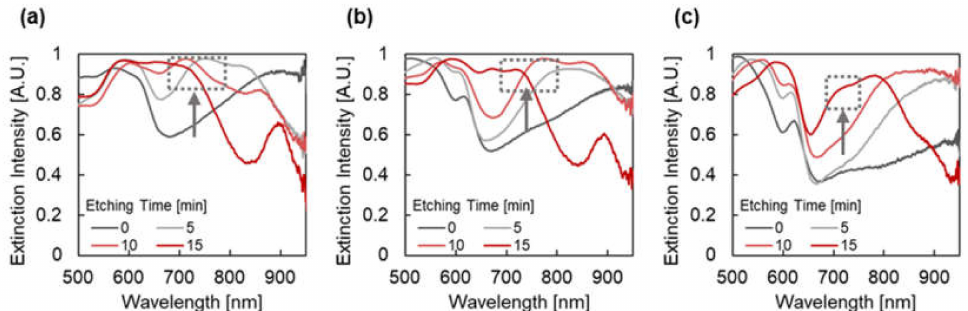
Figure 7. Extinction spectra of plasmonic devices fabricated through depositing Au with a thickness of ( a ) 100 nm, ( b ) 150 nm, and ( c ) 200 nm under wet conditions. The chart series in the graphs indicate the etching time (min), and the gray arrows and gray dashed squares indicate the shift of the extinction peaks, which was not found in some conditions; etching time 0 min and Au thickness 100 nm; etching time 0 and 5 min and Au thickness 150 nm; and etching time 0, 5 and 10 min and Au thickness 200